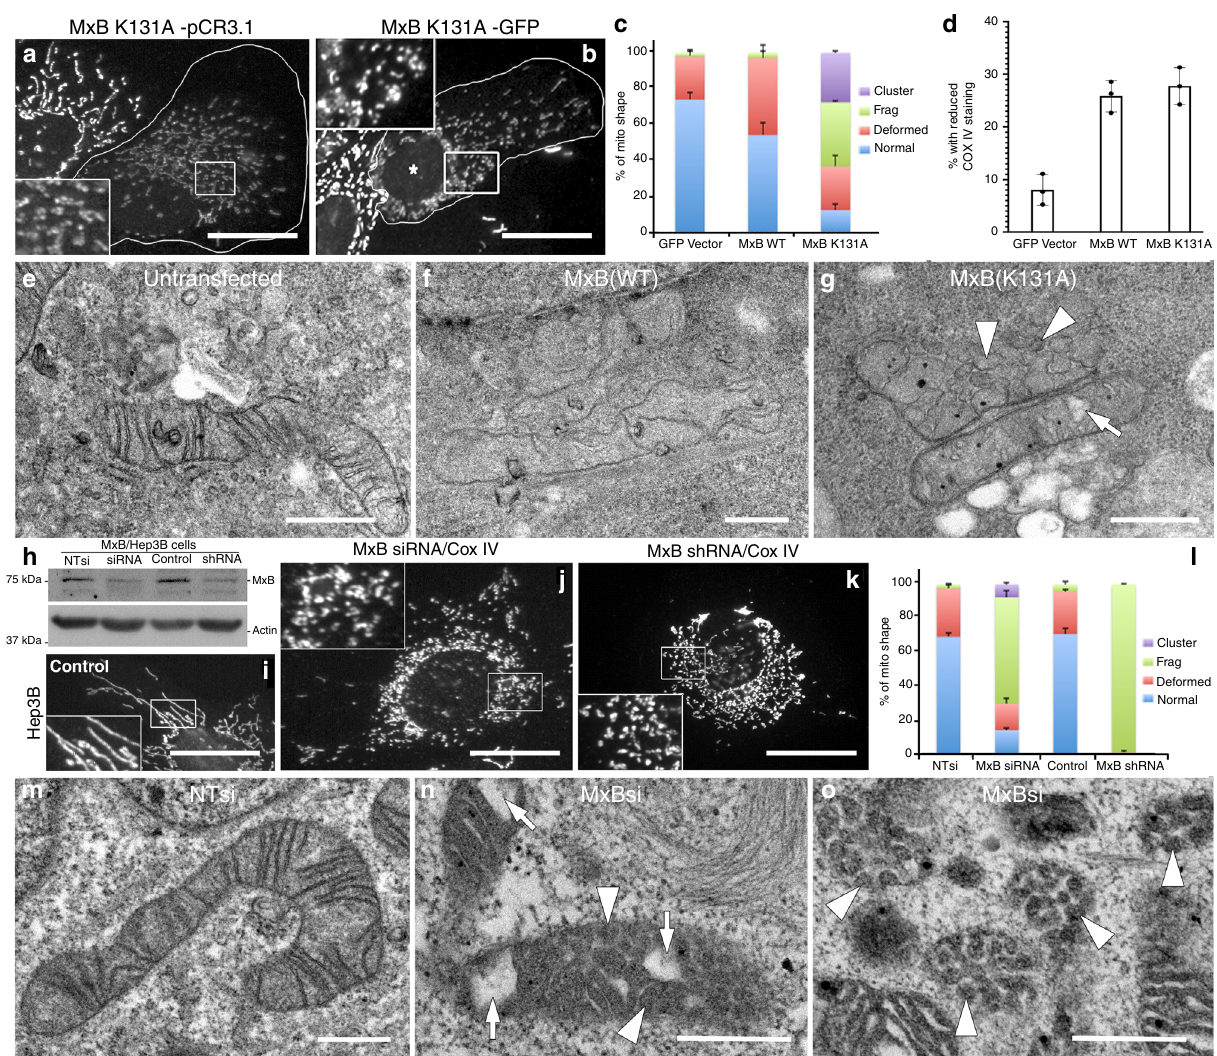
Fig. 3 Manipulation of MxB expression induces marked changes in mitochondrial morphology. a , b Fluorescence micrographs of transfected Hep3B cells (outlined in white border) expressing either an untagged ( a ) or GFP-tagged ( b ) GTPase-defective K131A mutant of MxB. Transfected cells possess mitochondria that are fragmented or distorted, or exhibit attenuated staining with antibodies to CoxIV compared with adjacent untransfected cells. c Bar graph representing morphological changes of mitochondria in control, WT, or mutant (K131A) MxB-expressing cells. Morphologies of clustered, fragmented, deformed, or normal mitochondria were counted in images of 636 Hep3B cells from three distinct experiments. d Graph representing the mean percentage of cells exhibiting a reduced CoxIV staining from 636 control or MxB-transfected cells from three distinct experiments. e – g Electron micrographs of mitochondria from Hep3B cells transfected to express MxB WT or K131A. Control cells ( e ) possess mitochondria with normal cristae, while cells expressing WT ( f ) or mutant (K131A) MxB ( g ) display mitochondria with reduced cristae and dark membrane vesiculations in the matrix (arrowheads). Scale bars, 10 μ m ( a , b ), 0.5 μ m ( e – g ). h – o Reducing MxB levels by siRNA or shRNA treatment promotes mitochondrial fragmentation . h Western blot of Hep3B cells treated for 5 days with siRNA or shRNA to MxB shows reduced protein levels. i – k Immuno fl uorescence of control Hep3B cells ( i ) or cells treated with siRNA ( j ) or shRNA ( k ) to reduce endogenous MxB levels and stained for CoxIV. Both treatments induced a marked change in mitochondrial morphology. l Bar graph representing morphological changes of mitochondria from 568 Hep3B cells from three distinct experiments. m – o Electron microscopy of control NTsi ( m ) or siRNA MxB-treated cells showing fragmented mitochondria with vesiculated cristae (arrowheads) and large vacuoles (arrows). ( c , d , l Data were analyzed using a two-tailed t -test, error bars indicate SD. Scale bars, 10 μ m ( i – k ), 0.5 μ m ( m – o